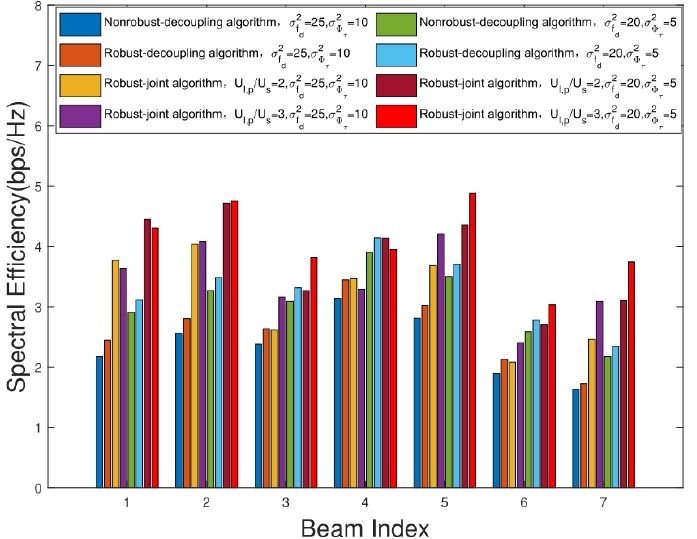
P . Figure 9. Change trajectory of system SE versus different transmission power thresholds P T T .